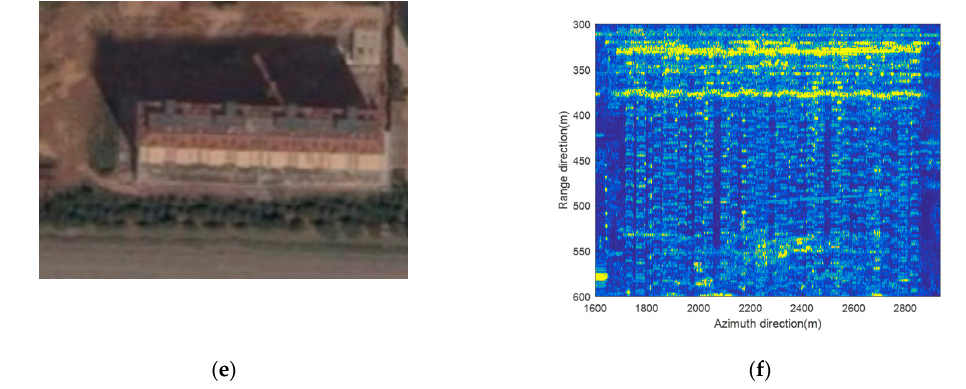
Figure 17. Results on the experimental TomoSAR data. ( a ) Original point clouds of the test building from one side looking; ( b ) Results of our proposed method; ( c ) Results of the RANSAC algorithm; ( d ) Results of the TomoSeed algorithm. ( e ) An optical image of the test area. ( f ) The SAR image of the test area with the Ku band.